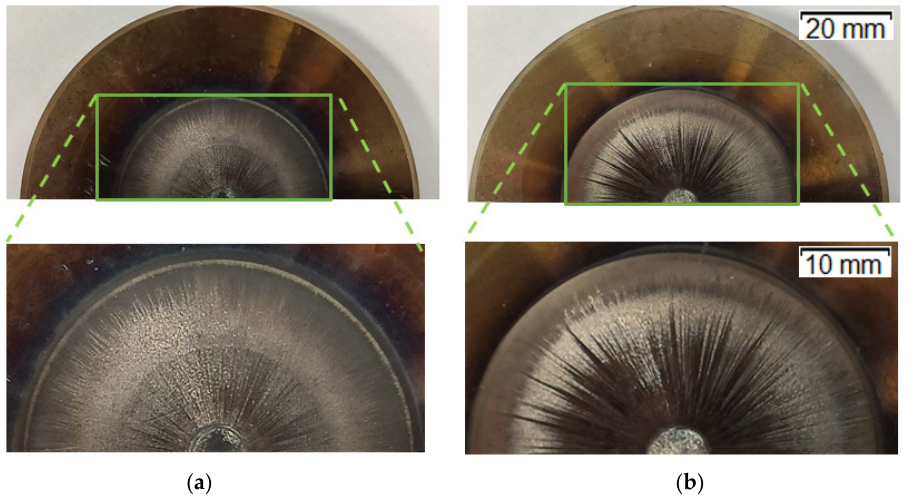
Figure 7. Macro-images of the punches with magnification of the working section: ( a ) a punch after producing 700 forgings, ( b ) a punch after producing 3000 forgings.